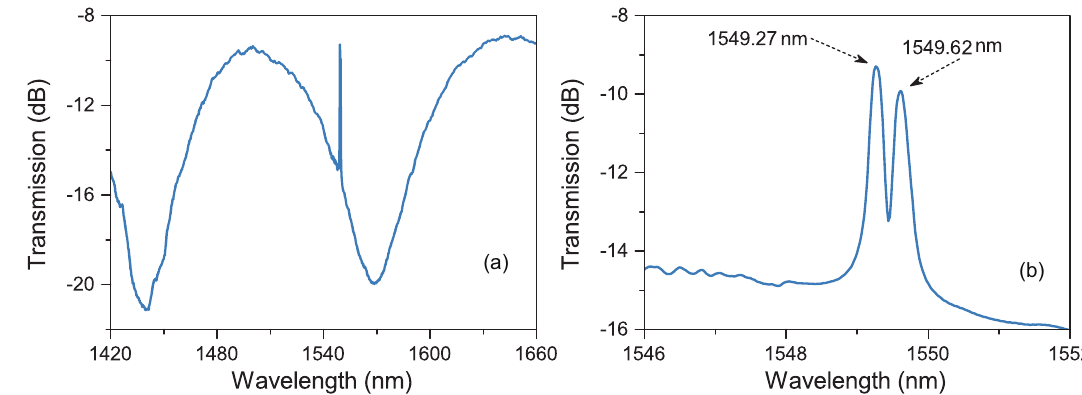
Figure 3. Spectra of the SAL PMF based Sagnac interference ( a ) and Bragg resonant peaks ( b ) after grating